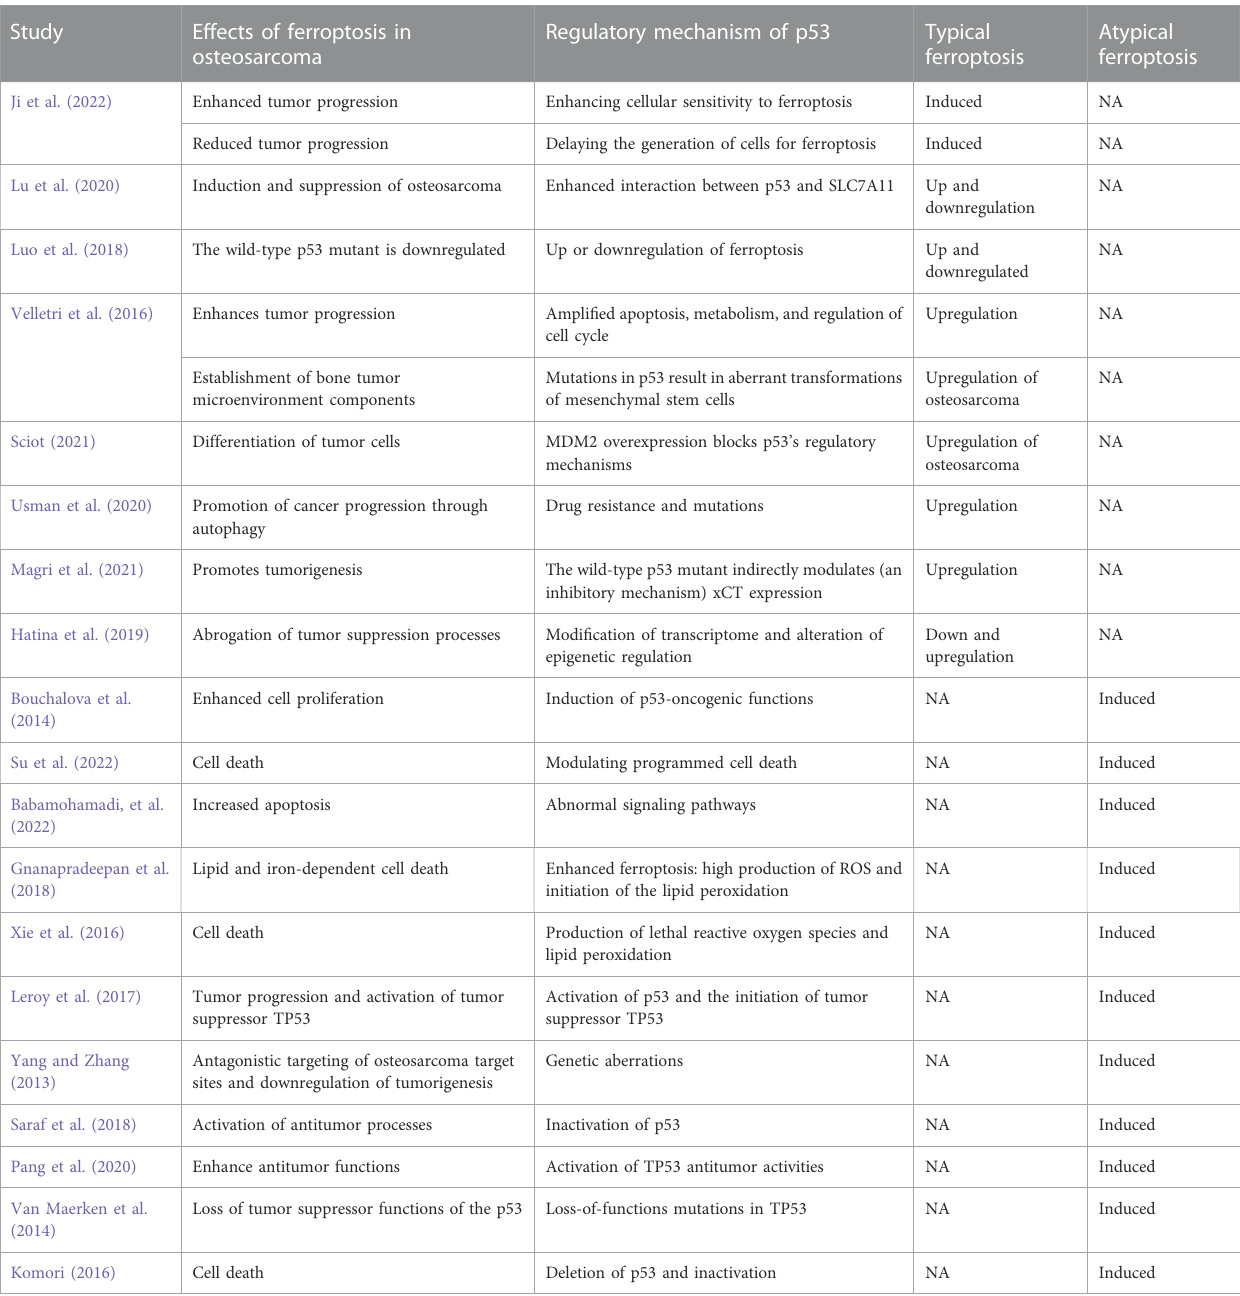
TABLE 2 Basic features of included